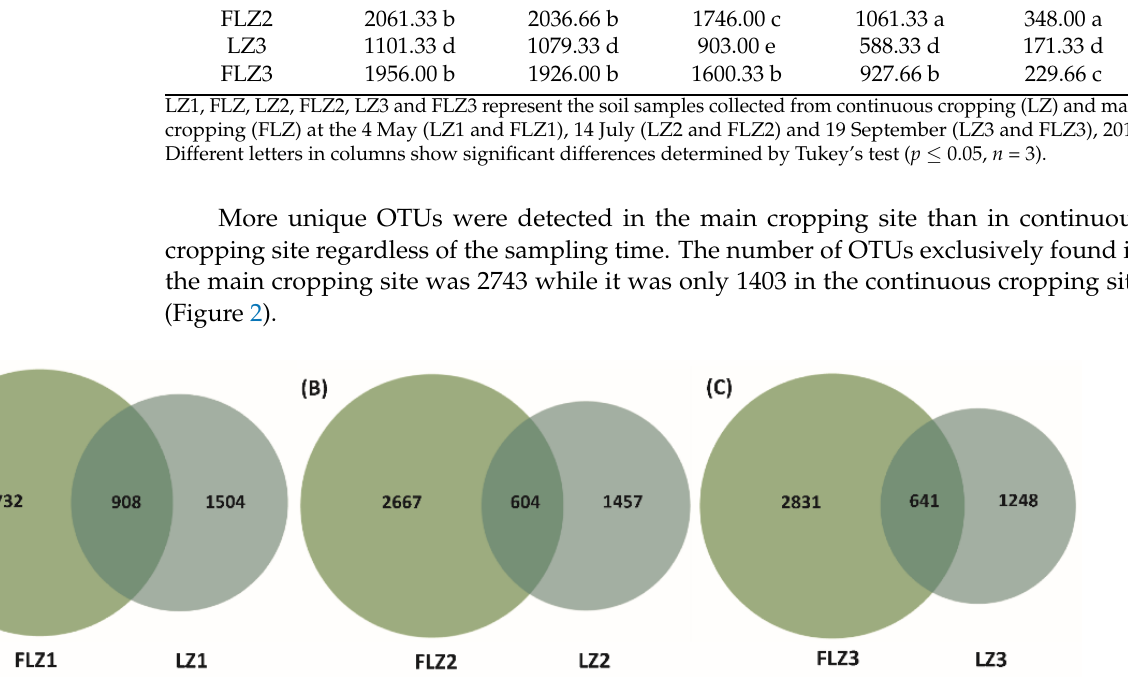
Table 3. Statistical table of classification and classification of status identification results by OTU in different soil samples.